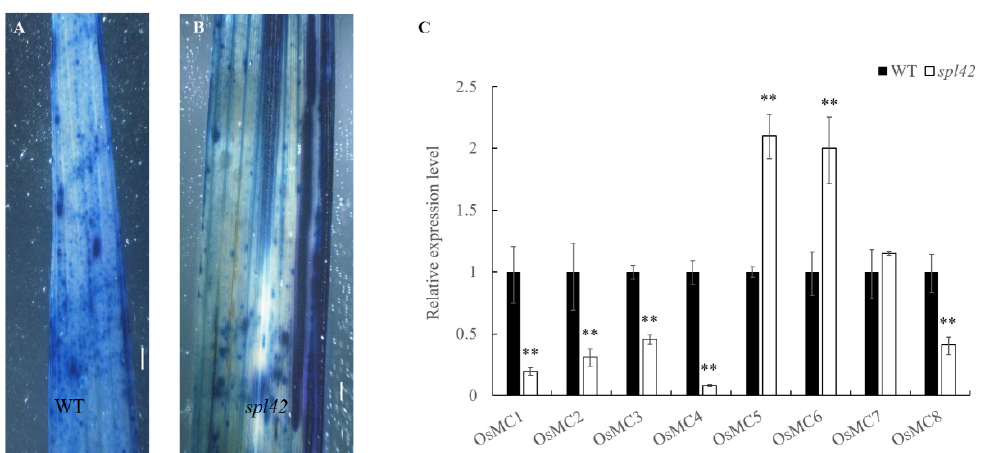
Figure A1. Trypan blue staining experiment and meta caspase gene family expression analysis. ( A , B ) Trypan blue staining in wild type (WT) and mutant spl42 leaves. Scale bars = 0.1 cm. ( C ) qRT-PCR analysis for meta caspase family genes. Error bars represent ± SD ( n = 3). Asterisks indicate a significant difference between WT and the spl42 plants by Student’s t -test, ** p < 0.01.